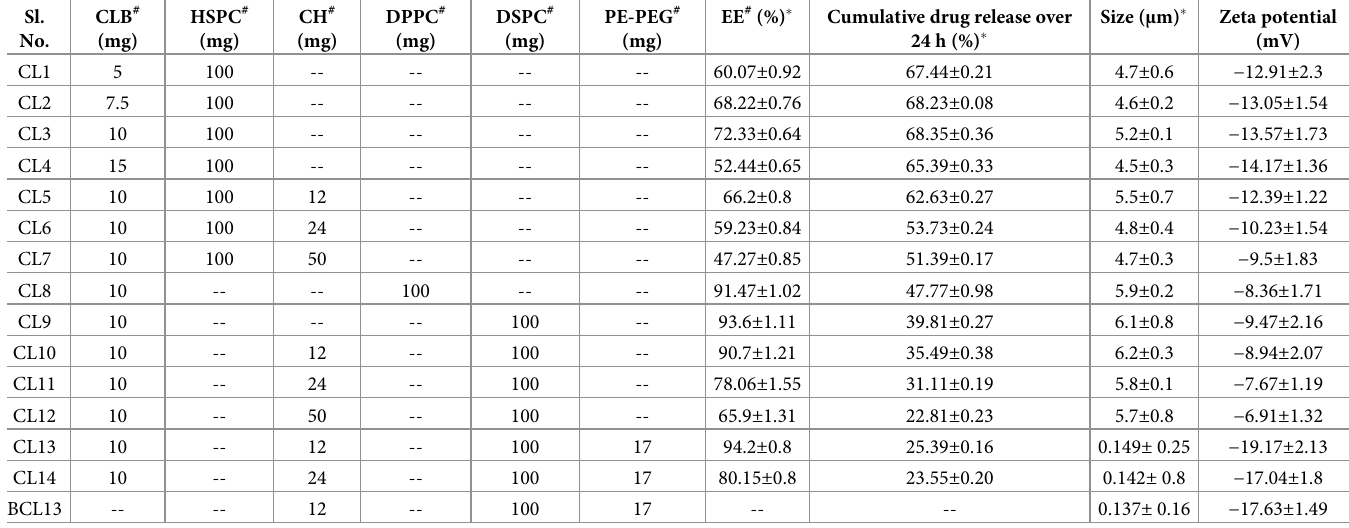
Table 1. Formulae for various CLB loaded liposome